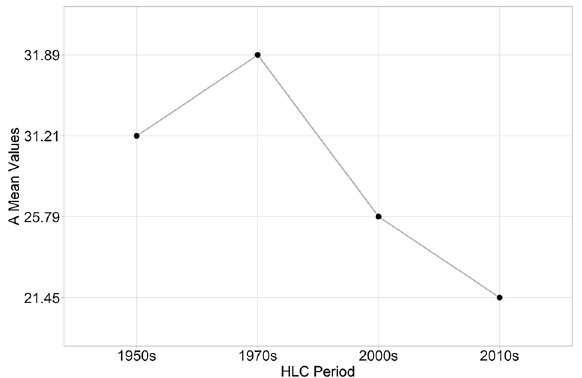
Figure 12. The A mean values in the four chronological periods: 1950s, 1970s, 2000s, 2010s). Image generated with software RStudio Desktop 2022.07.2 + 576 (https:// www. rstud io.